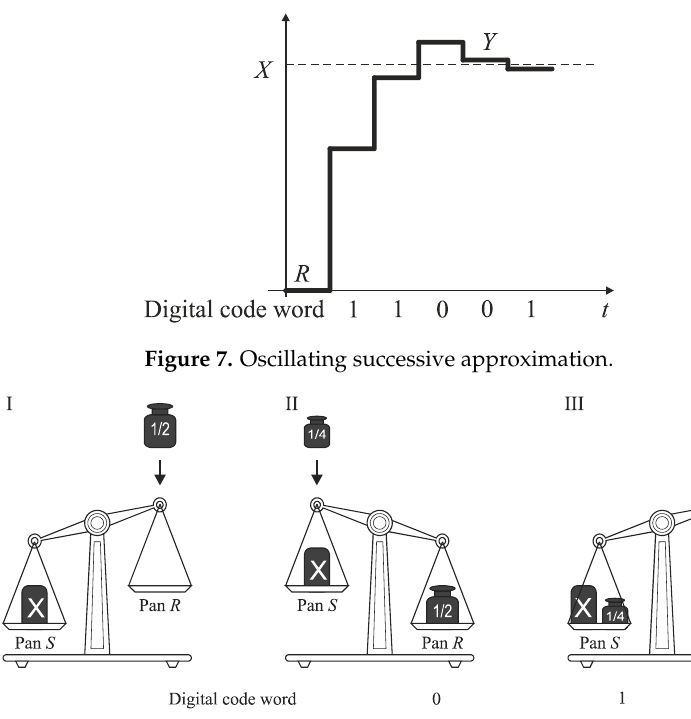
Figure 8. Illustration of monotone successive approximation. ( I ),The mass X is placed in the pan S , and the weight is put on the pan R ; ( II ), The accumulated mass on the pan R is larger than the mass